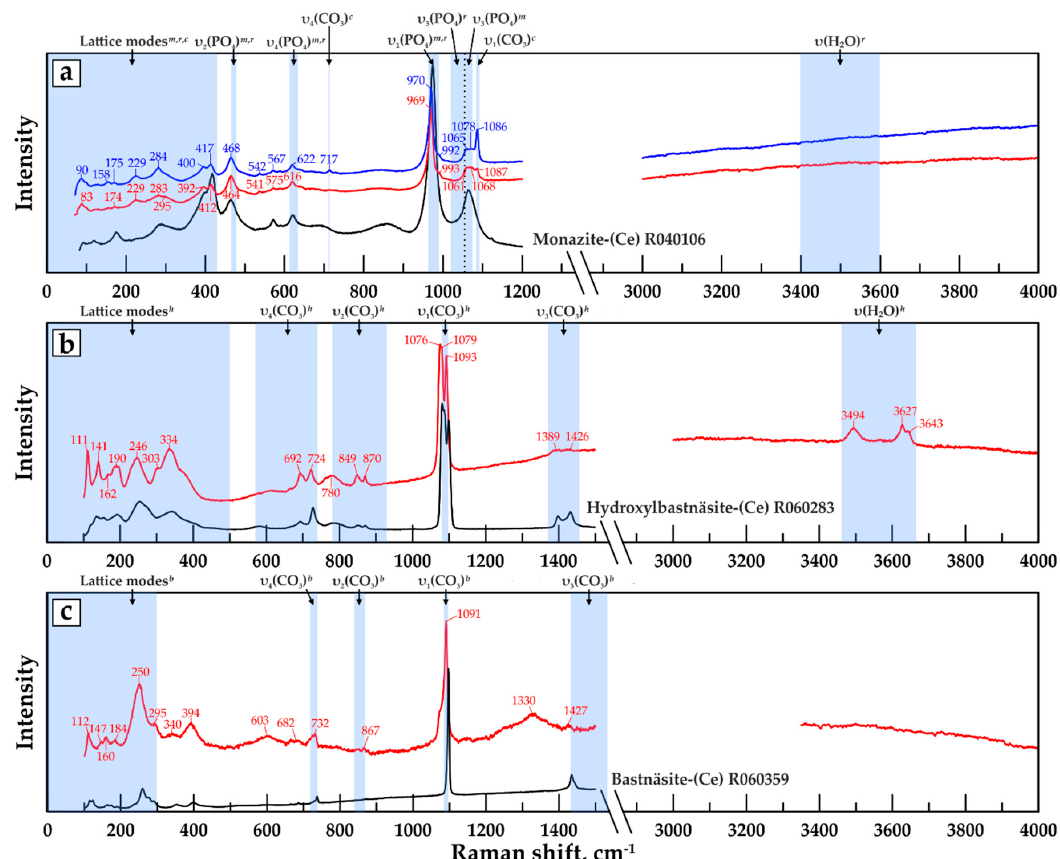
Figure 9. Raman spectra of ( a ) monazite-(Ce), ( b ) hydroxylbästnasite-(Ce), and ( c ) bästnasite-(Ce) from high-Ti carbonatites of the Petyayan-Vara (red and blue lines). Spectra (black lines) and ID references of minerals are from the RRUFF database [107]. The positions of the main bands (see Table 2) of monazite ( m ), rhabdophane ( r ), calcite ( c ), hydroxylbästnasite ( h ), and bästnasite ( b ) are plotted.